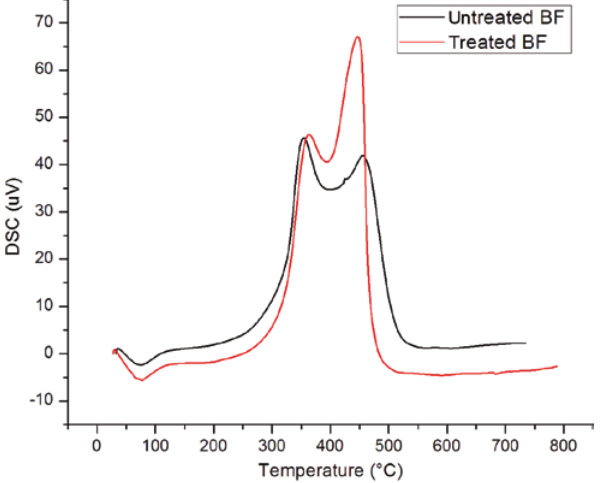
Figure 11: DSC thermogram of untreated BF and treated BF. Figure 12: FTIR spectra of (a) untreated BF and (b) treated BF.